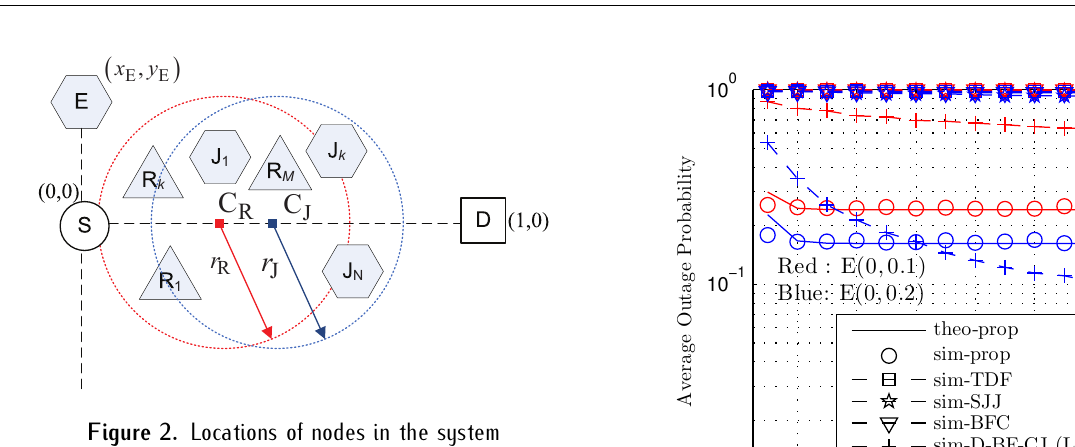
in the proposed method (also in the D-BF-CJ). Thus, this figure validates the e ff ective exploitation of the spatial diversity with multiple jammers in the proposed method. Fig. 5 evaluates the AOPR as a function of the target transmission rate. We set N = 3 and M = 6. Although the pre-log factor in the secrecy rates in the proposed method is 1 / 3, the AOP of the proposed method is still better than the TDF, SJJ and BFC methods when R t changes. Because the distance between S and